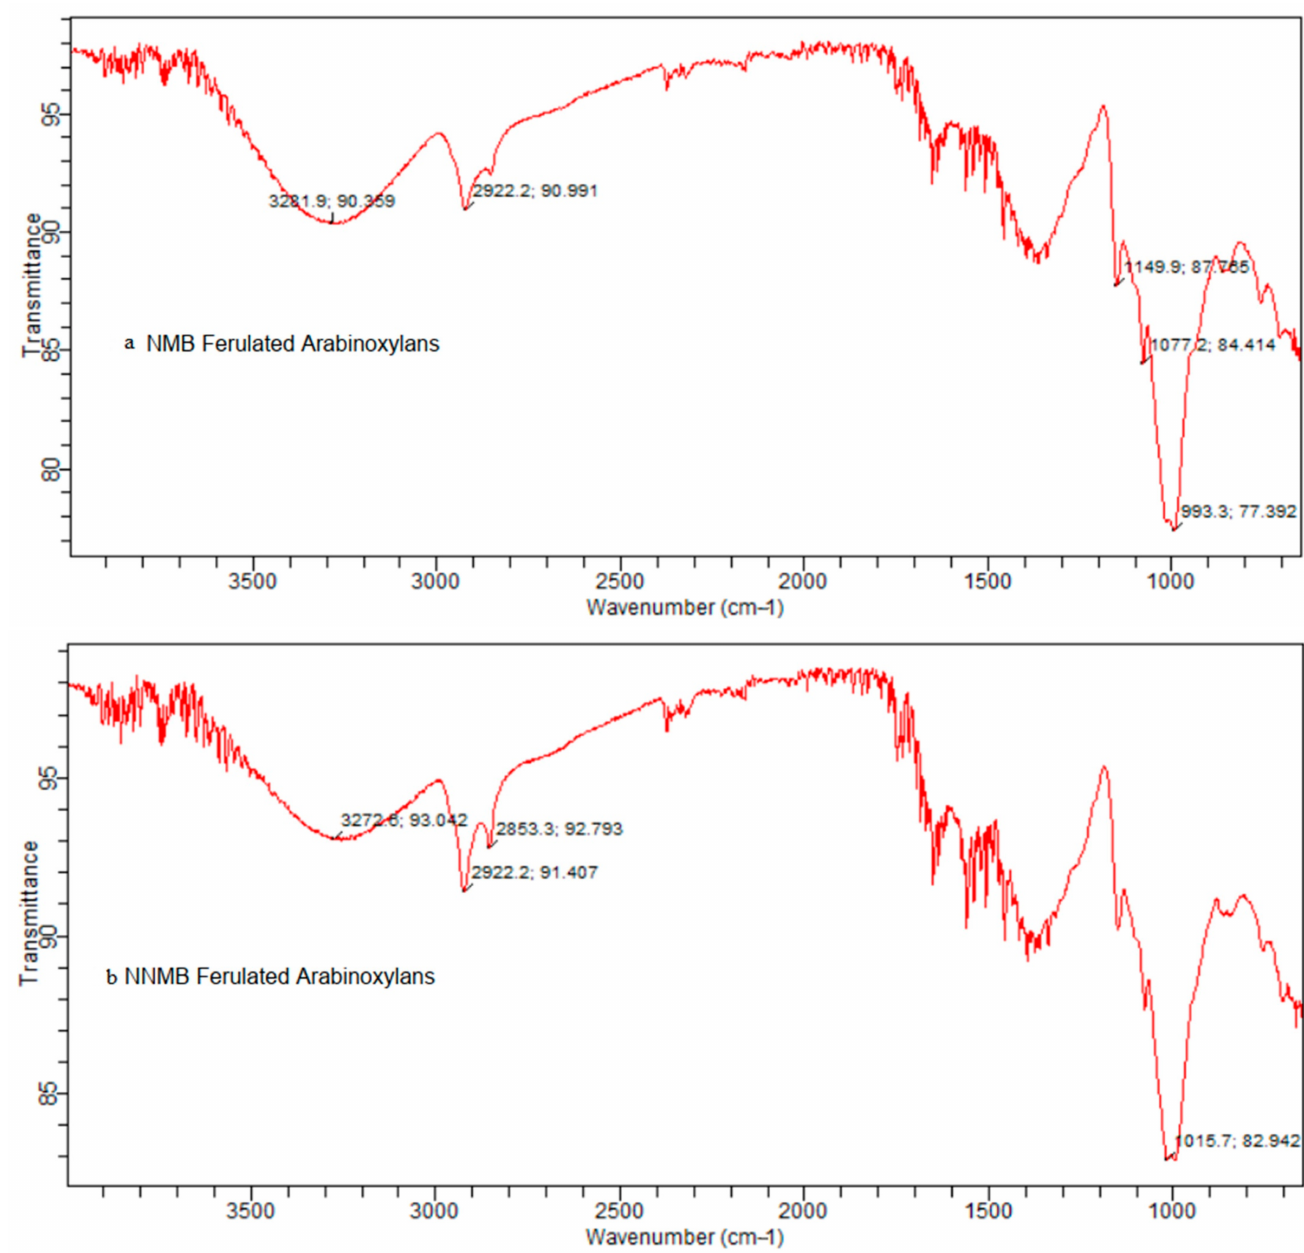
Figure 2. FTIR spectrum of ( a ) NMB and ( b ) NNMB ferulated arabinoxylans. The bands 1650 cm − 1 and 1533 cm − 1 are associated with the amide I and amide II bands, respectively, and the phenolic acids have specific absorption bands in the 1500– 1800 cm − 1 range. In current spectra of NMB and NNMB FAXs, phenolic compounds including ferulic acid divided in an initial band vibration of 1521 cm − 1 showed a strong aromatic ring and foremost absorption bands at 1692, 1620 and 1600 cm − 1 . Both spectrum peaks at 1680 and 1550 cm − 1 NNMB and NMB FAXs are related to amide I and II, respec- tively. A clear observation of the FTIR spectrum of the cross-linked materials reveals that NNMB and NMB polymers are not significantly affected by the cross-linking process of arabinoxylans and ferulic acid. The current results spectrum reported that the NMB FAXs spectra band at 3281 cm − 1 resembles the stretching of the OH groups and the band at 2922 cm − 1 the CH2 groups, while ferulated arabinoxylans of NNMB showed the band